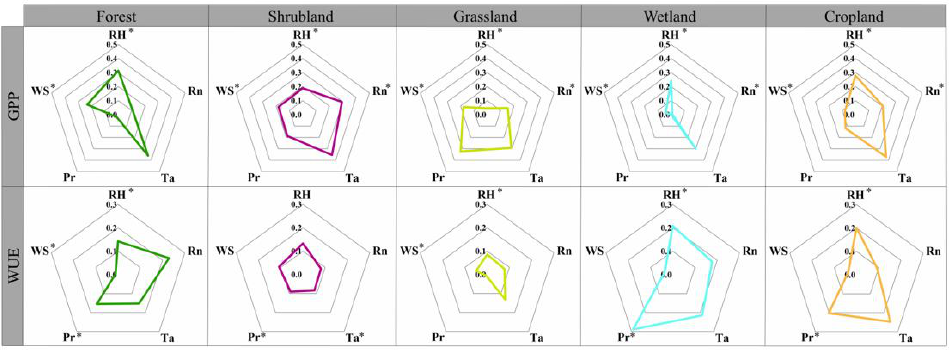
Figure 12. Average correlation coefficients (0~1, unitless) of GPP and WUE with climatic factors for each vegetation type. * indicates the negative correlation.